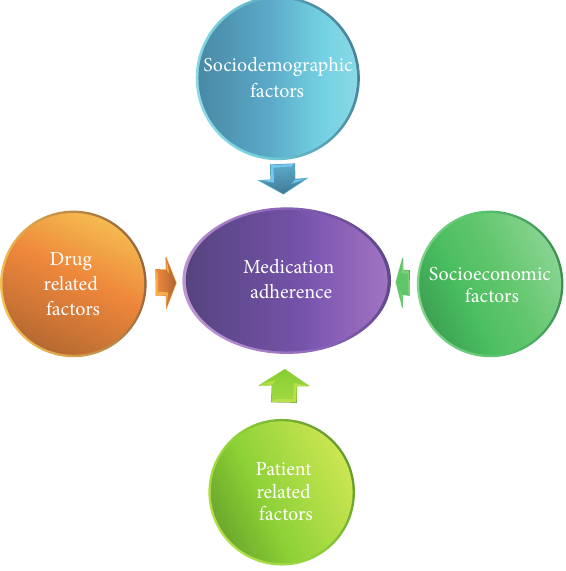
Figure 1: Structural